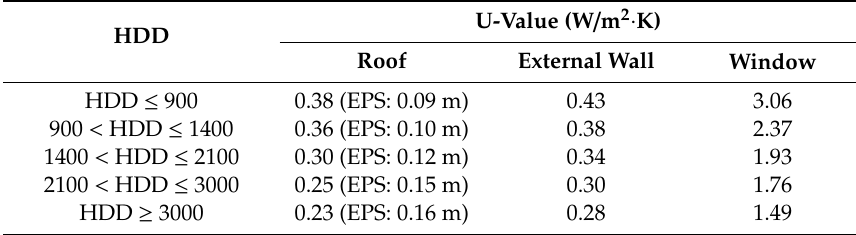
Table 2. Envelope components thermal transmittance (U-values) for the case study small o ffi ce building model depending on zones